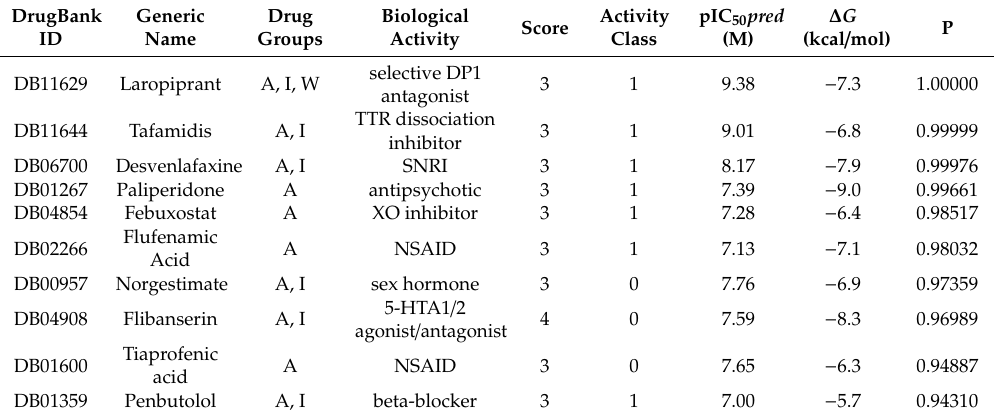
Table 6. Top 10 secondarily ranked potential TRPA1 inhibitors with good central nervous system (CNS) exposure based on the binary logistic regression equation used as a global prediction model and blood brain barrier (BBB) permeation